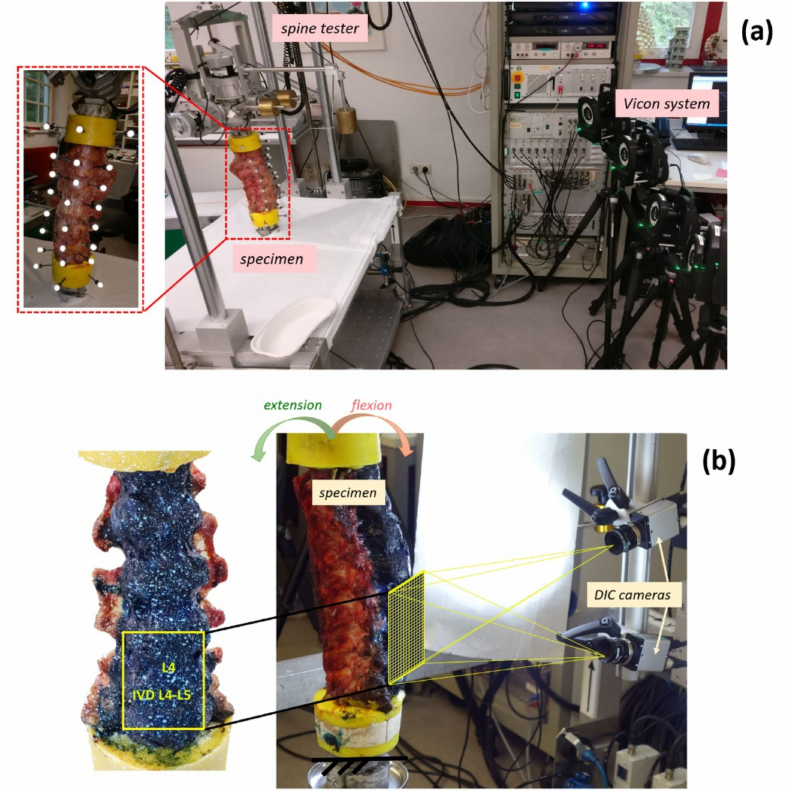
Figure 1. Overview of the test configuration and data acquisition systems. The top part ( a ) shows the test session where motion was measured: the spine segment with the markers (three on each vertebra) is visible on the left. The spine tester and four of the six cameras of Vicon system are visible on the right. The bottom part ( b ) shows the session where strains were measured: the specimen with the white-on-black speckle pattern for the DIC analysis is visible on the left. The field of view recorded by the DIC cameras is indicated. On the right, the specimen mounted in the spine tester in front of the DIC system is